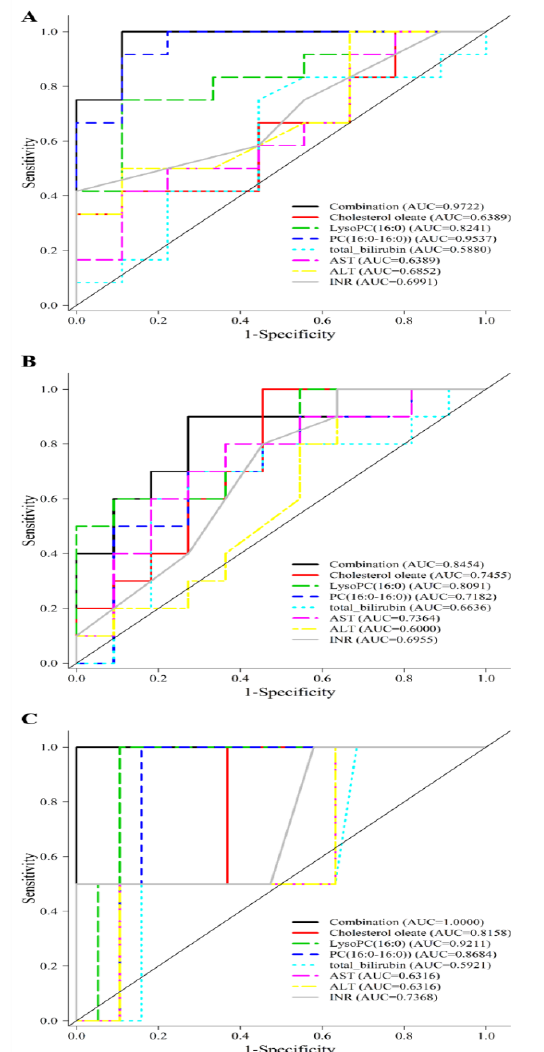
Figure 5. Prediction of early allograft dysfunction, all-cause in-hospital mortality, long hospital stay in validation cohort. ( A ) A combination of cholesterol oleate, PC (16:0/16:0), and lysoPC (16:0) metabolites gives an AUC of 0.7884 in the prediction of in-hospital mortality in the study group. ( B )A combination of cholesterol oleate, PC (16:0/16:0), and lysoPC (16:0) metabolites gives an AUC of 0.9722 in the prediction of EAD in the validation group. ( C ) A combination of cholesterol oleate, PC (16:0/16:0), and lysoPC (16:0) metabolites gives an AUC of 0.8454 in the prediction of hospital stay